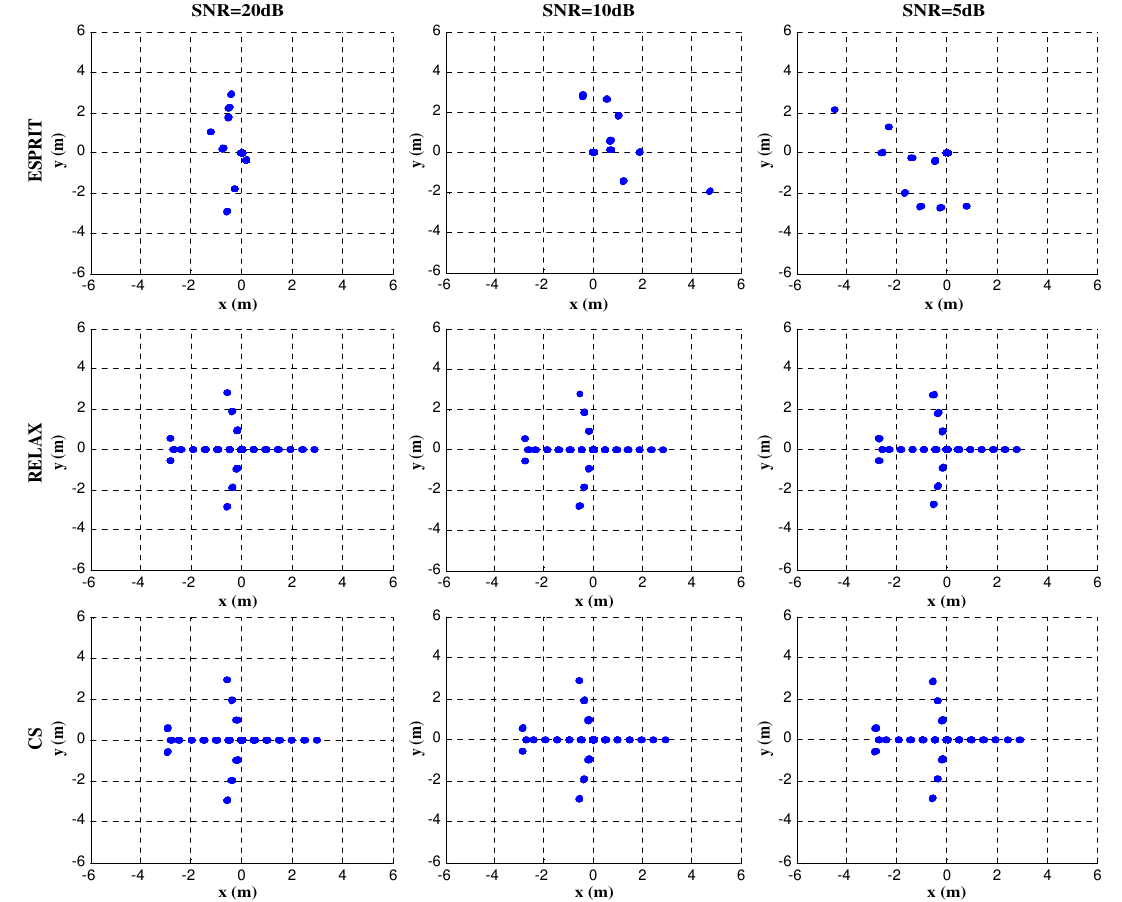
Figure 7. Passive inverse synthetic aperture radar (ISAR) imaging results with different reconstruction methods under different signal-to-noise ratios